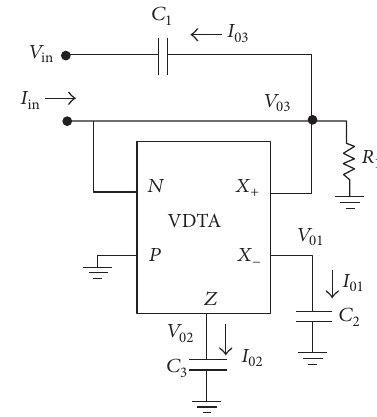
Figure 3: Proposed VM and CM mode SIMO